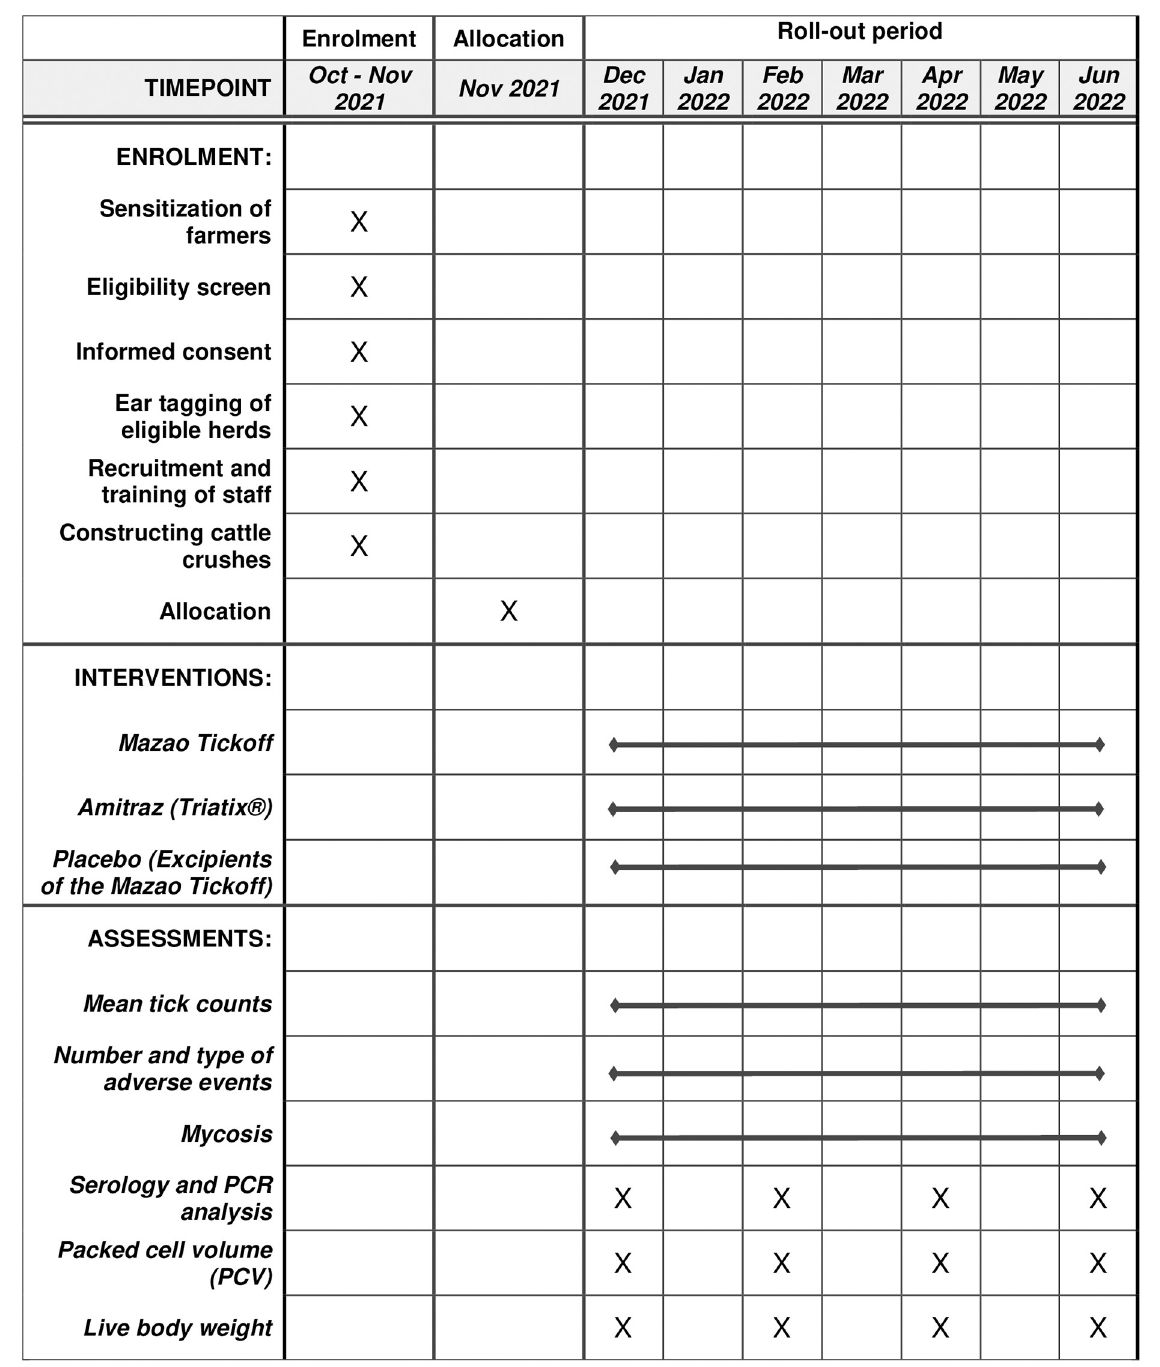
Fig 2. Schedule of enrolment, interventions, and